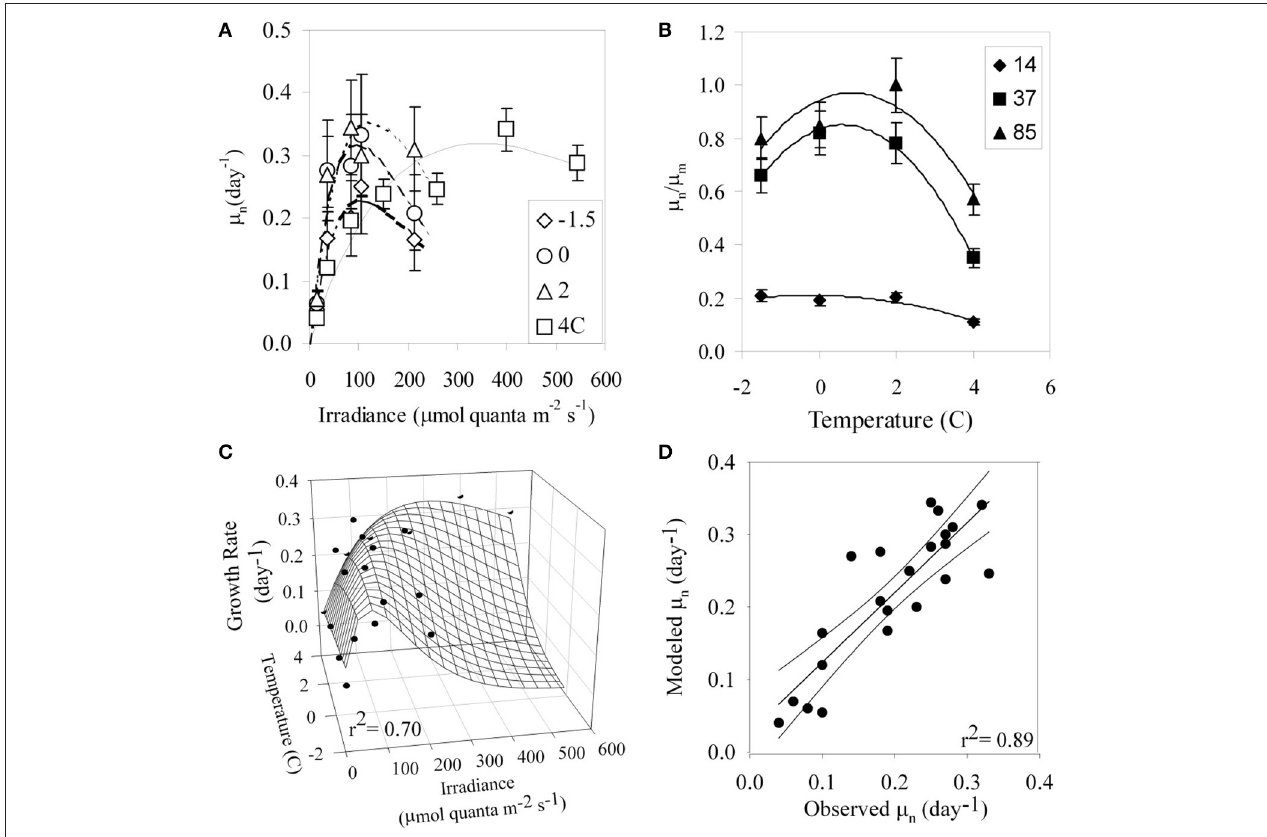
FIGURE 1 | (A) Specific growth rates ( µ n , day − 1 ) of P. antarctica with respect to irradiance for growth temperatures ranging from − 1.5 to 4 ◦ C. (B) Relative growth rate ( µ n / µ m ) with respect to temperature for irradiances in units of µ mol quanta m − 2 s − 1 . (C) An empirically-derived model for growth rate based on combined limitation of light and temperature. The continuous surface is the model prediction and discrete points are experimental observations. (D) Modeled vs. observed µ (day − 1 ) based on Equation